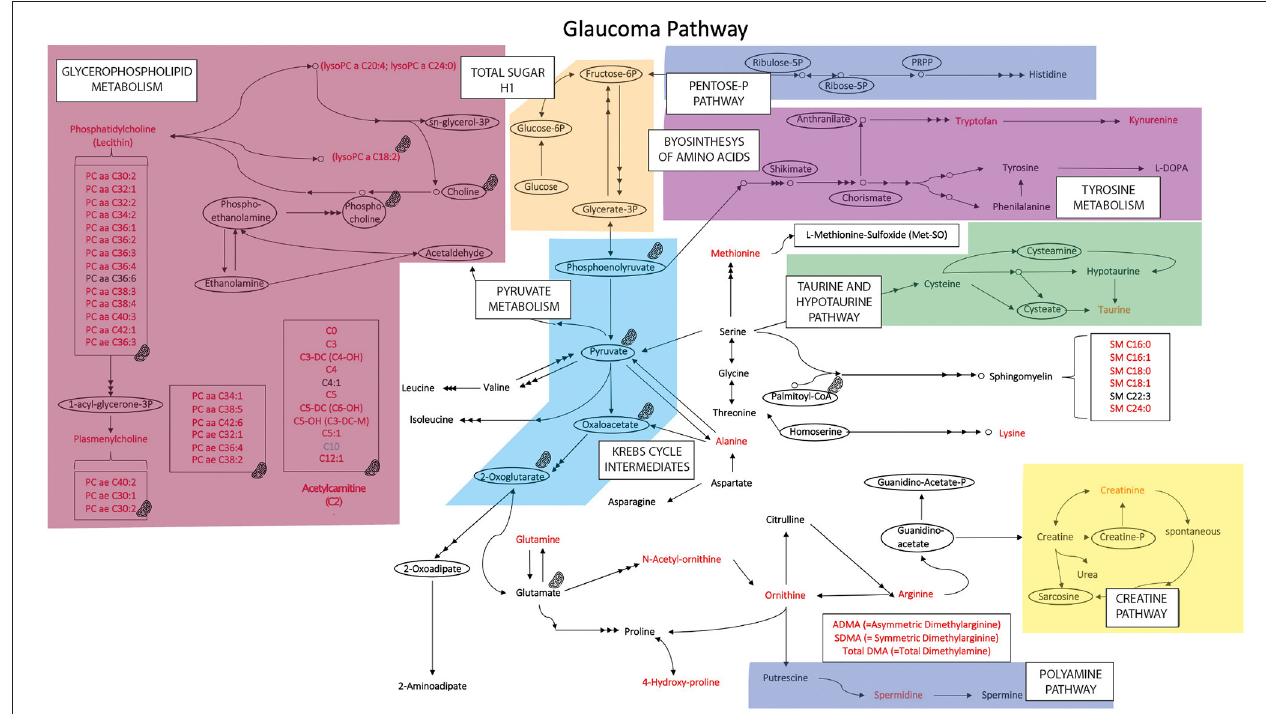
FIGURE 5 | Metabolic pathway map summarizing the results obtained in glaucoma samples. In red the metabolites whose concentration is increased in the glaucoma samples (compared with values in samples from healthy controls), in light blue the metabolite whose concentration is reduced in glaucoma samples. Compounds within ellipses were not determined in this study; they are included as nodes in metabolism interconnections. Areas in color represent main metabolic pathways. Icon indicates compound/group of compounds that may be in mitochondria or are directly/indirectly related to